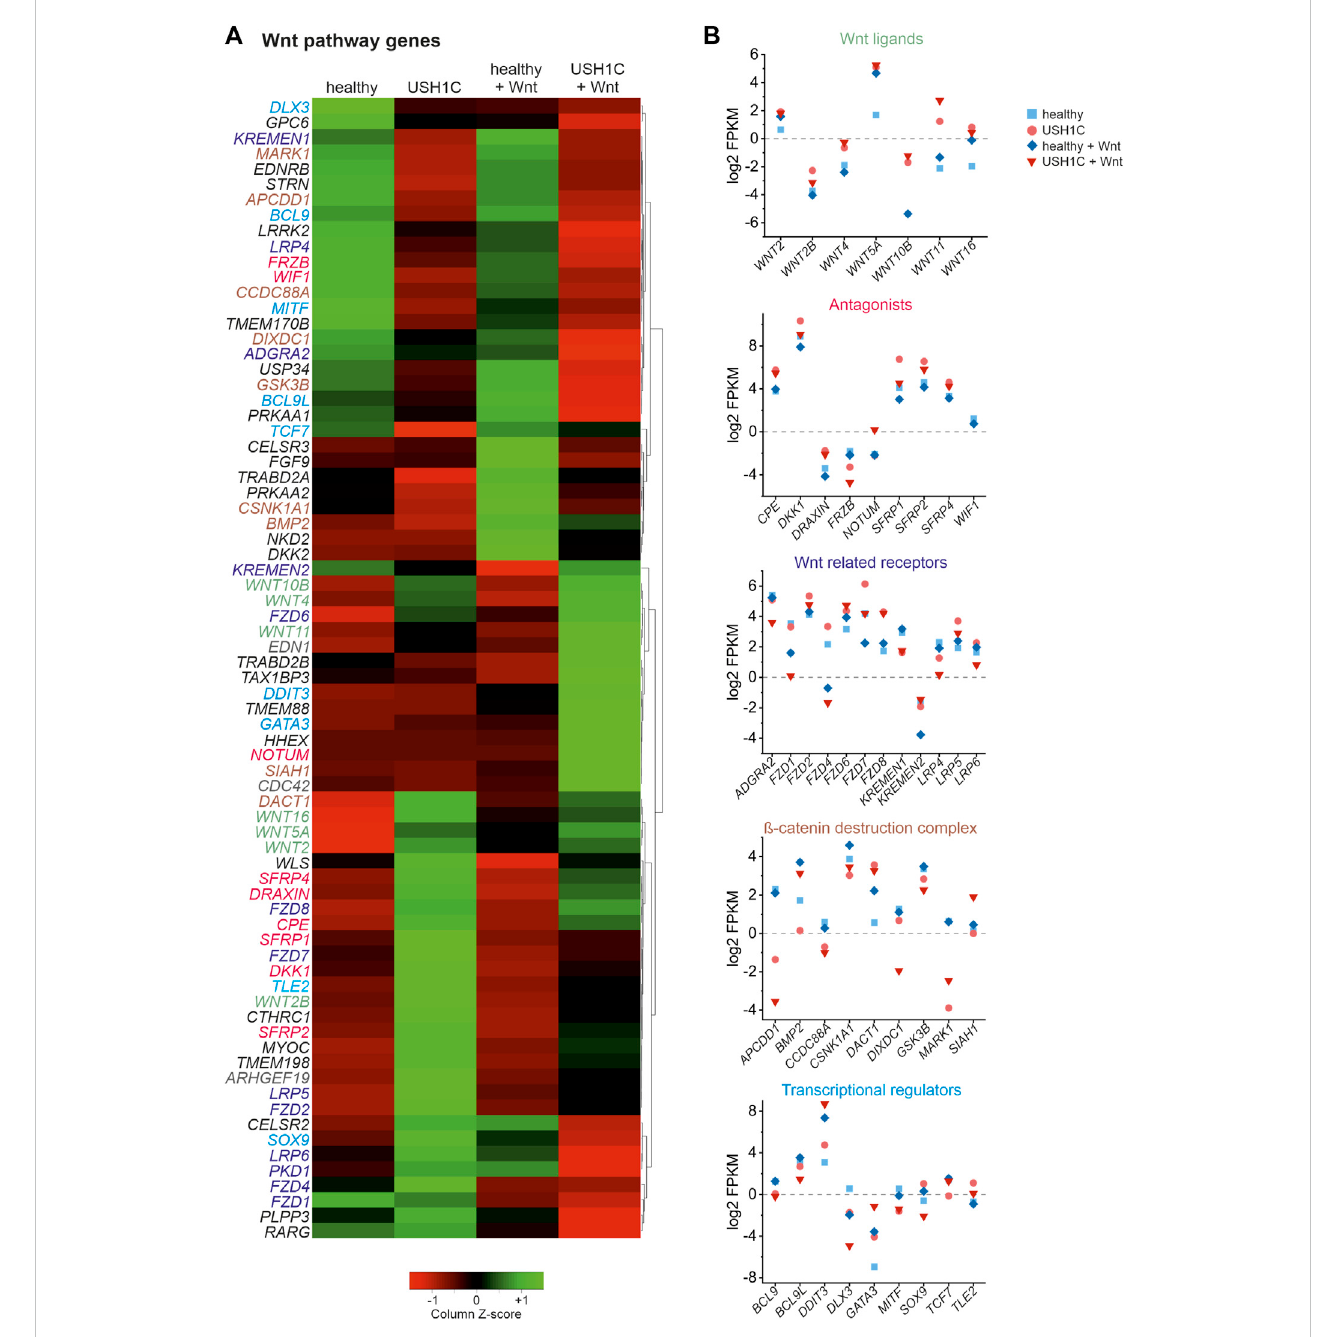
FIGURE 5 RNAseq reveals differential expression of Wnt signaling pathway genes in USH1C R31*/R80Pfs*69 patient-derived fi broblasts. (A) Heatmap showing transformed FPKM-values scaled by z-score identifying 74 differentially regulated Wnt signaling pathway genes in unstimulated and Wnt stimulated healthy (column 1 and 3) and USH1C R31*/R80Pfs*69 patient-derived ( USH1C ) fi broblasts (column 2 and 4). Red areas correspond to a relative downregulation in gene expression, whereas green areas represent a relative upregulation. (B) Log2 transformed FPKM-valuesshow the expression levels of Wnt pathway genes blotted due to their area of action within the Wnt signaling pathway for unstimulated and Wnt stimulated healthy and USH1C R31*/R80Pfs*69 (USH) fi broblasts,